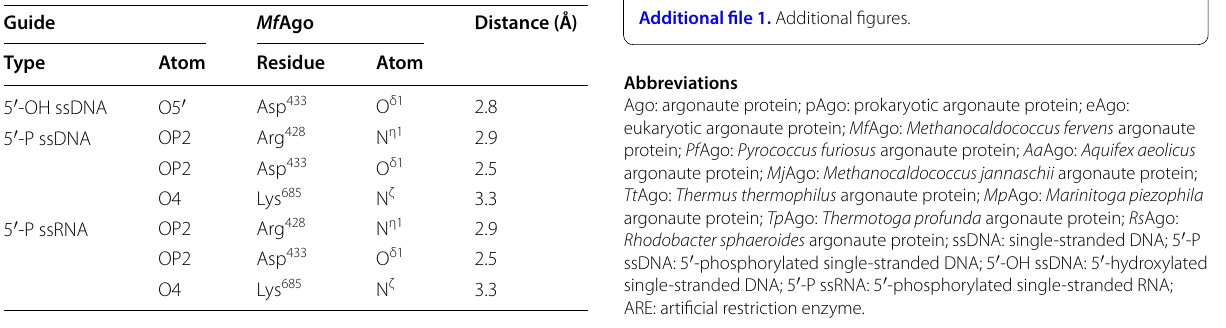
Additional file Table 3 Residues of Mf Ago to interact with the 5 ʹ end